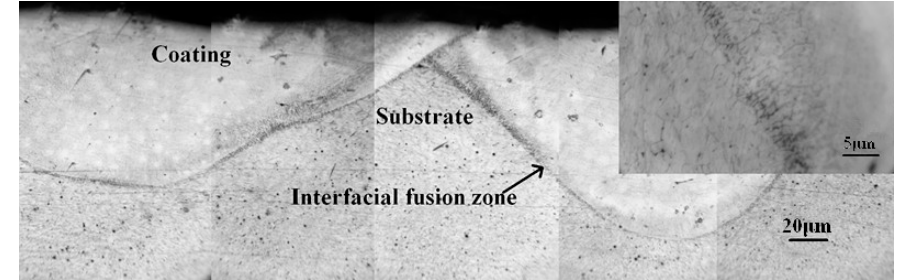
Figure 4. Macro-morphology of the transverse section of coating fabricated by laser cladding.